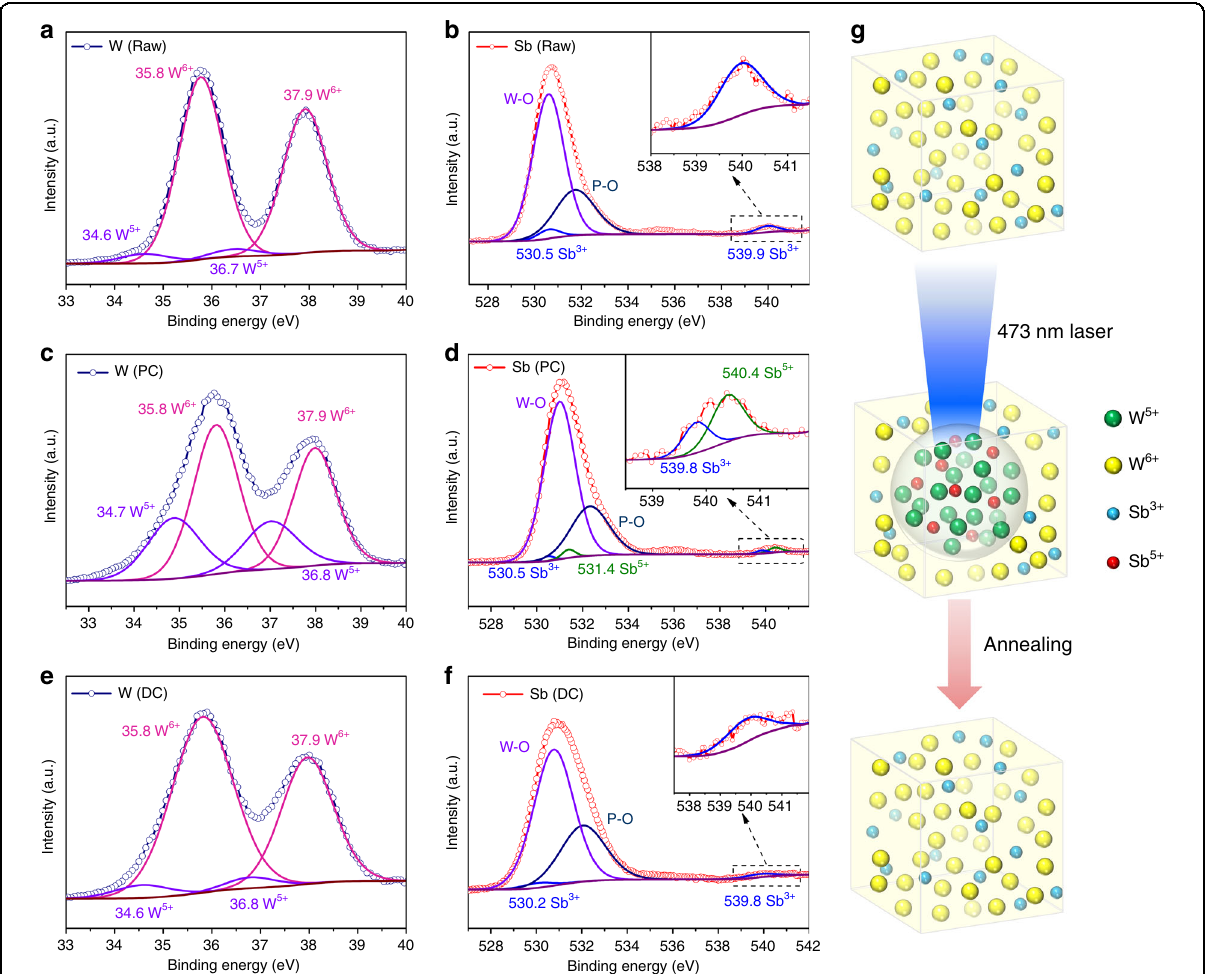
Fig. 3 Reversible photochromic mechanism. a , c XPS spectra of W element in WPG-Sb1 before ( a ) and after ( c ) photochromism (PC) (151.26W cm − 2 , 15 min). b , d XPS spectra of Sb element in WPG-Sb1 before ( b ) and after ( d ) photochromism (151.26 W cm − 2 , 15 min). e , f XPS spectra of W ( e ) and Sb ( f ) elements in the decolorated (DC) glass caused by heat-treatment at 300 °C for 10 min. g Proposed reversible photochromism mechanism of tungsten phosphate